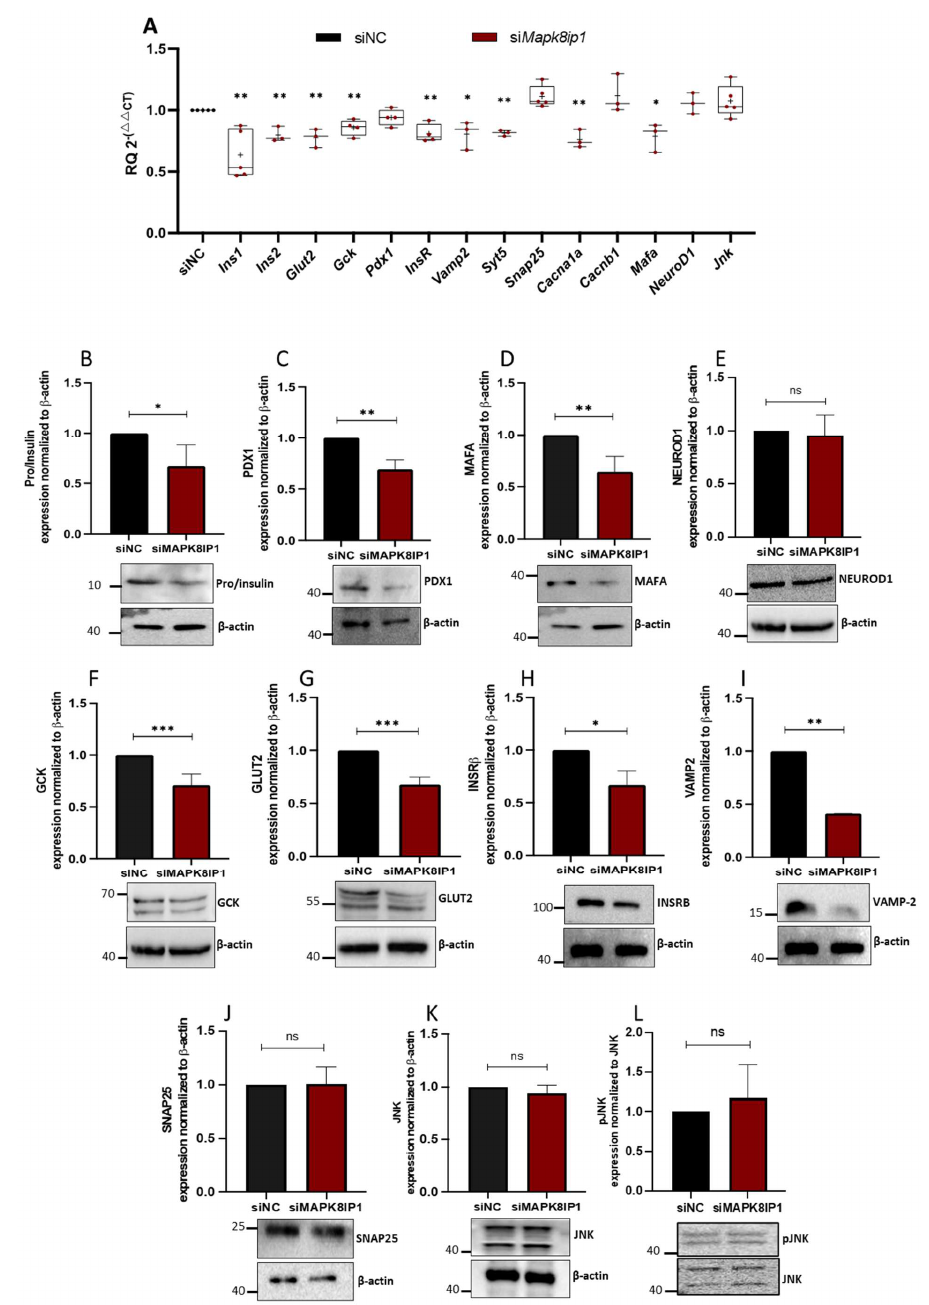
Figure 4. Impact of Mapk8ip1 silencing on the expression of β -cell function genes. Total mRNA/protein was extracted from Mapk8ip1 -silenced cells (si Mapk8ip1 ) or siRNA negative control cells (siNC) after 48 h of transfection and subjected to qRT-PCR or Western blot analysis. ( A ) qPCR expression analysis of Ins1 , Ins2 , Glut2 , Gck , Pdx1 , Insr , Vamp2 , Syt5 , Snap25 , Cacna1a , Cacnb1 , MafA , NeuroD1 , and Jnk in Mapk8ip1 -silenced cells compared to those in control cells. Data were obtained from at least three independent experiments.Western blot analysis of Pro/insulin ( B ), PDX1 ( C ), MAFA ( D ), NEUROD1 ( E ), GCK ( F ), GLUT2 ( G ), INSR β ( H ), VAMP2 ( I ), SNAP25 ( J ), JNK ( K ) and pJNK ( L ) relative to the endogenous control protein β -actin (pJNK levels shown relative to JNK) in Mapk8ip1 -silenced cells and control cells (lower panels). Corresponding fold changes in the intensities of the Western blot bands are shown above each blot. Data were obtained from three independent experiments (see Supplementary Figures S2–S4). * p < 0.05, ** p < 0.01, *** p < 0.001, ns; not significant. Bars above histograms represent SD of the mean values. Statistical analyses were performed using Student t